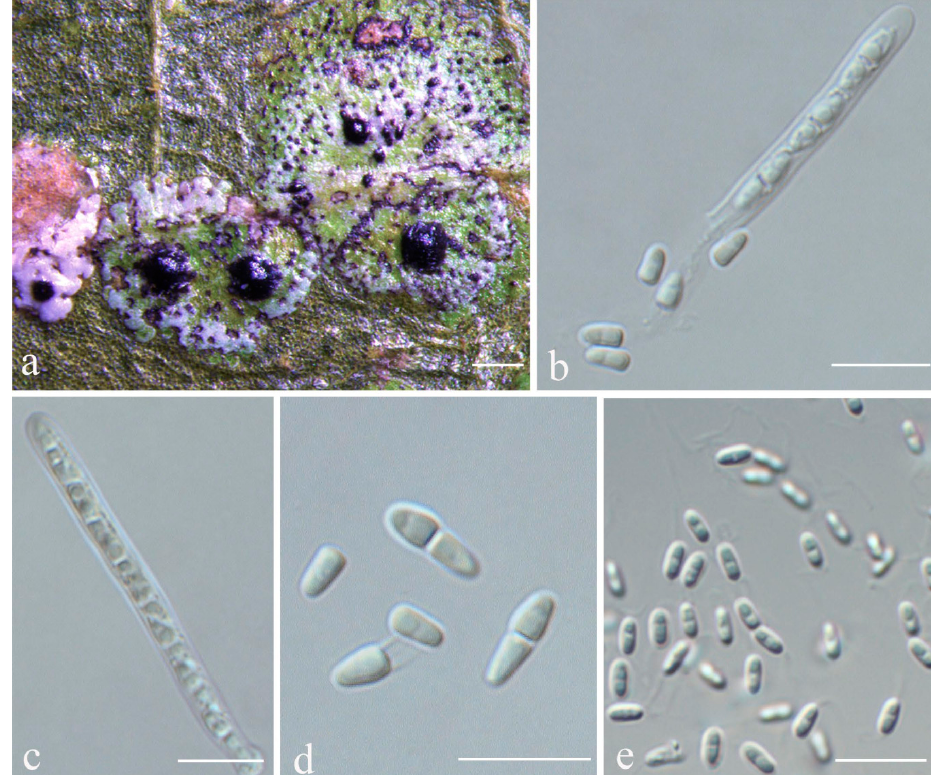
Figure 8. Strigula intermedia sp. nov. (holotype, HMAS–L0139177). ( a ) Thallus; ( b , c ) asci and ascospores; ( d ) ascospores; ( e ) macroconidia. Scale bars: ( a ) = 300 μ m, ( b – e ) = 10 μ m.